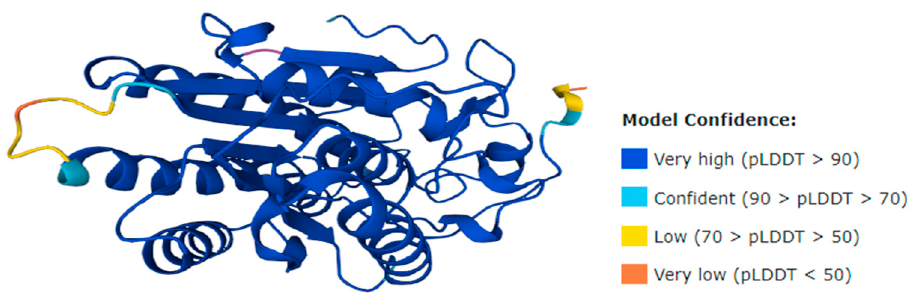
Figure 10. Glucose and ribitol in the rice bran product developed based on the structure model.